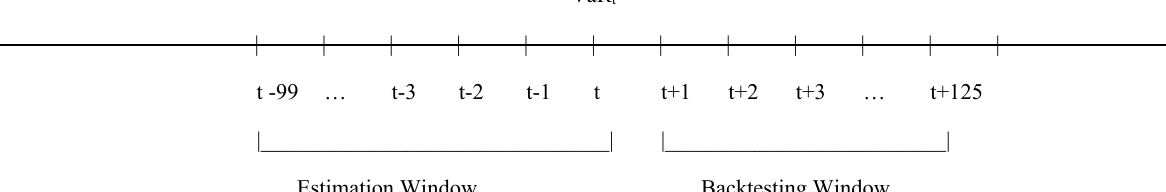
Figure 1. Returns distribution for the six stocks.